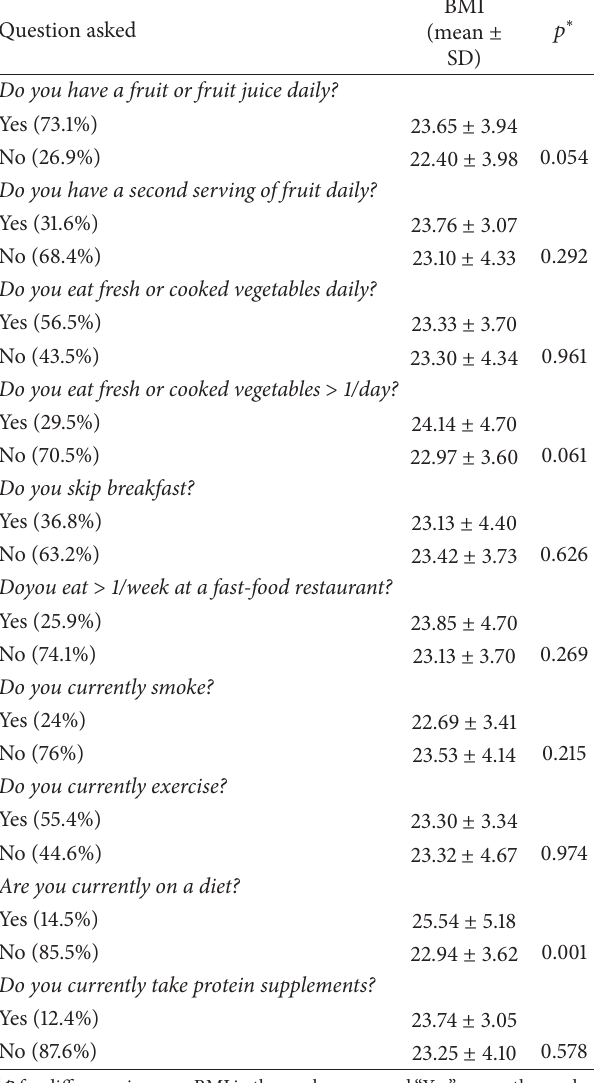
Table 2: Association between dietary/personal habits and mean BMI in all study